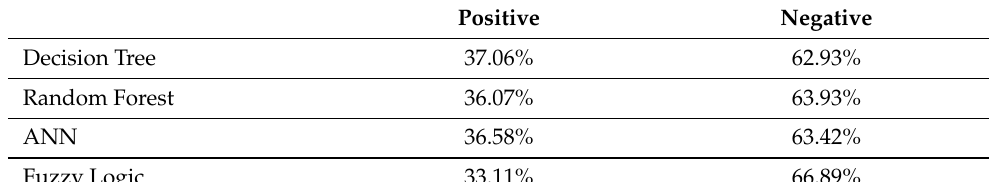
Table 4. Positive and negative decision rate for each algorithm in the simulator.